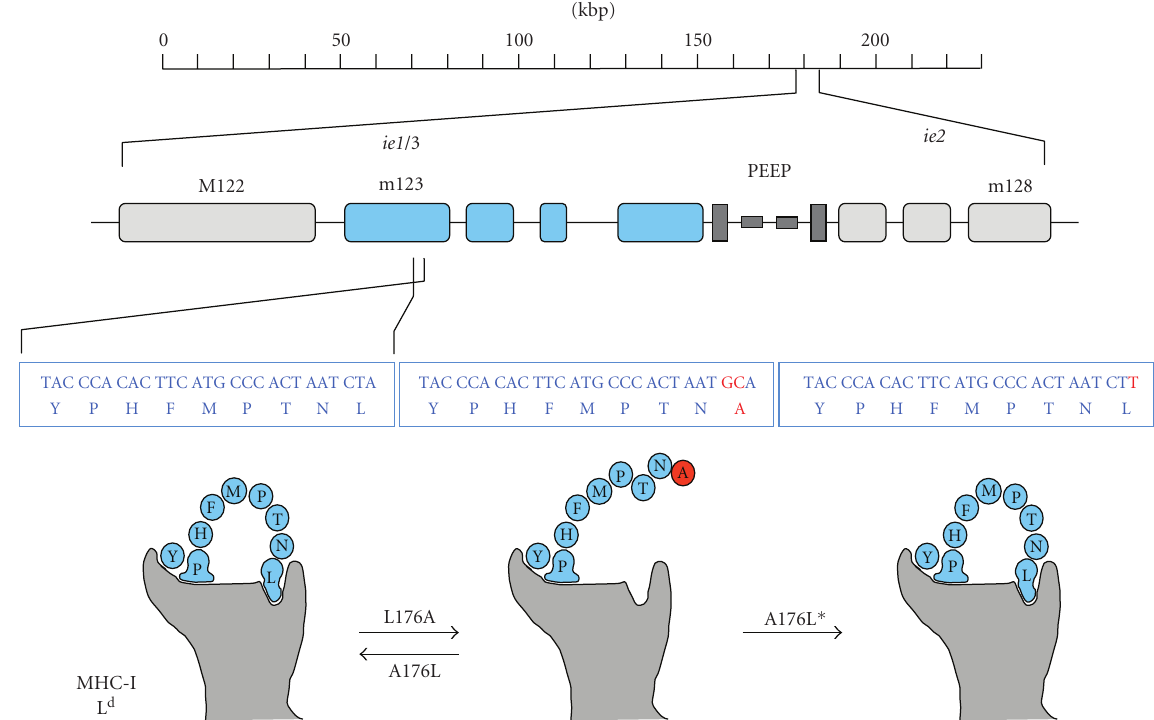
Figure 2: Loss-of-presentation mutagenesis of antigenic peptides. (Top) Genome size scale of mCMV and bidirectional gene pair architecture of the major immediate-early (MIE) locus, with the promoter-enhancer-enhancer-promoter (PEEP) region flanked to the left by the ie1/3 transcription unit (ORFs m123/M122) and to the right by gene ie2 (ORFm128) [86]. Exons are symbolized by boxes, with blue boxes representing the four exons specifying the IE1 mRNA. The coding sequence for the antigenic IE1 peptide is located in exon 4. (Center) Nucleotide and corresponding amino acid sequences for the authentic and mutated IE1 peptides, with mutations being highlighted in red. (Bottom) Artwork models illustrating the binding of authentic and mutated IE1 peptides to the presenting MHC class-I molecule H-2-L d through the C-terminal anchor residue. The mutation is highlighted in red. L176A: mutant; A176L: authentic revertant; A176L ∗ : “wobble” revertant maintaining a single nucleotide polymorphism as a genetic marker distinguishing it from WT and authentic revertant.